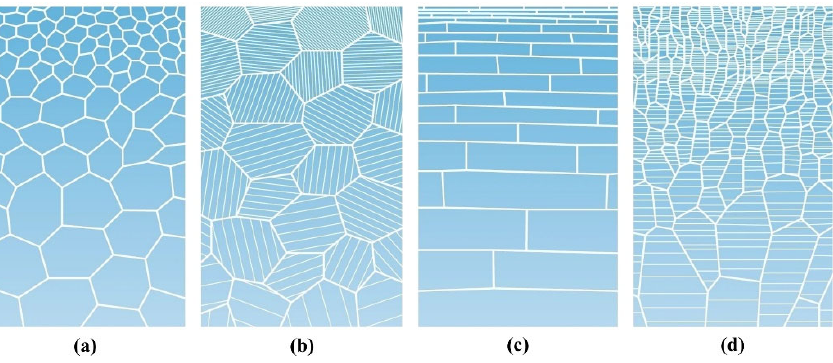
Figure 8. The classification of gradient nanostructure [27]: ( a ) grain size gradient; ( b ) twin thickness gradient; ( c ) lamellar thickness gradient; ( d ) columnar size gradient.